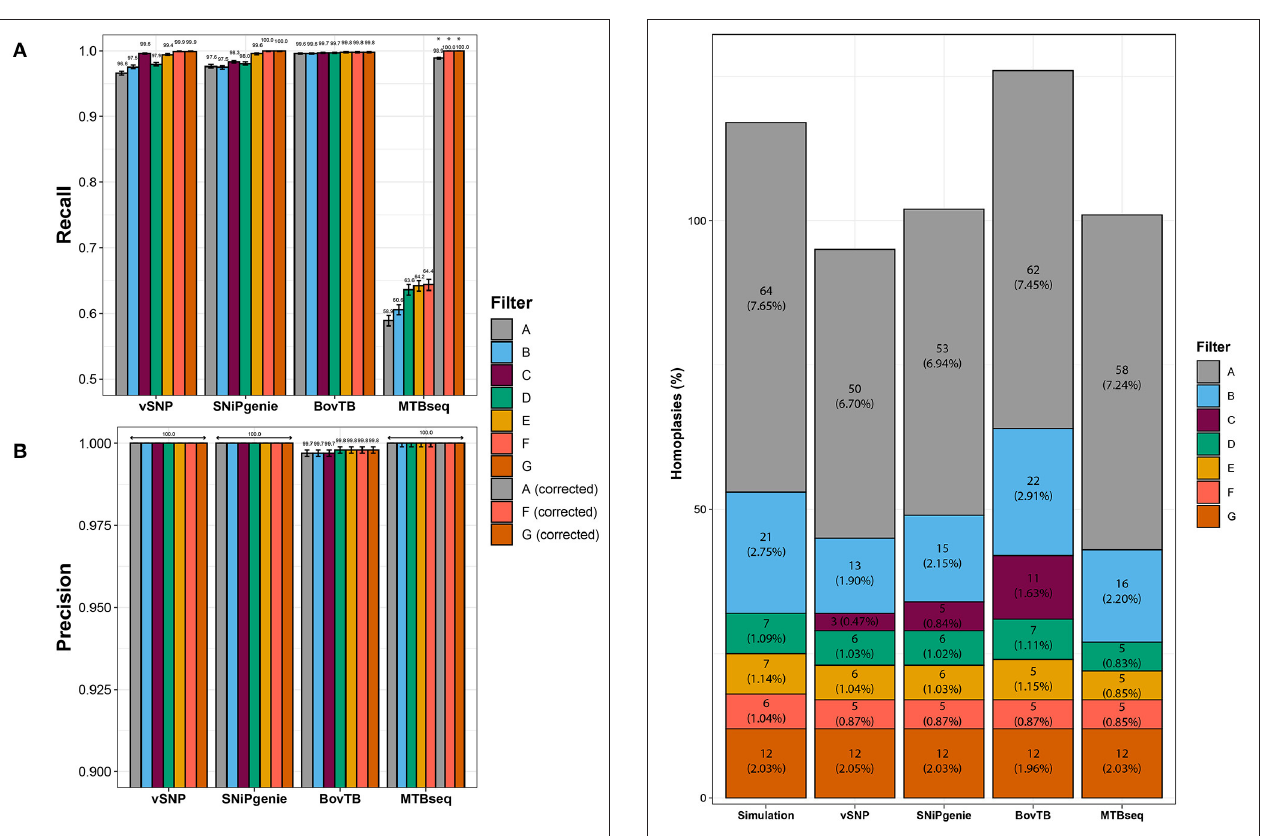
FIGURE 3 | Effect of filtering in the total number of homoplasic positions per pipeline identified by HomoplasyFinder. The percentage represents the proportion of homoplasic positions from the total number of identified positions using each specific